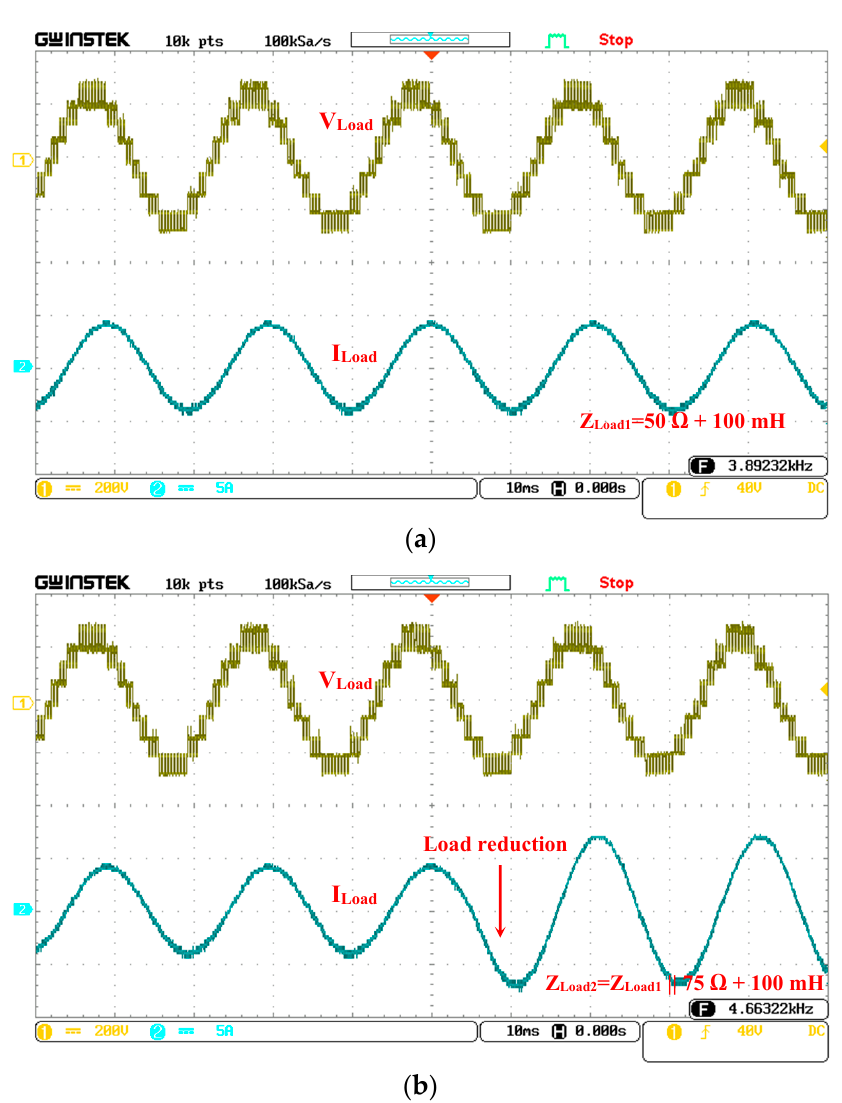
Figure 11. Output voltage/current under, ( a ) constant load; ( b ) step change in the load.